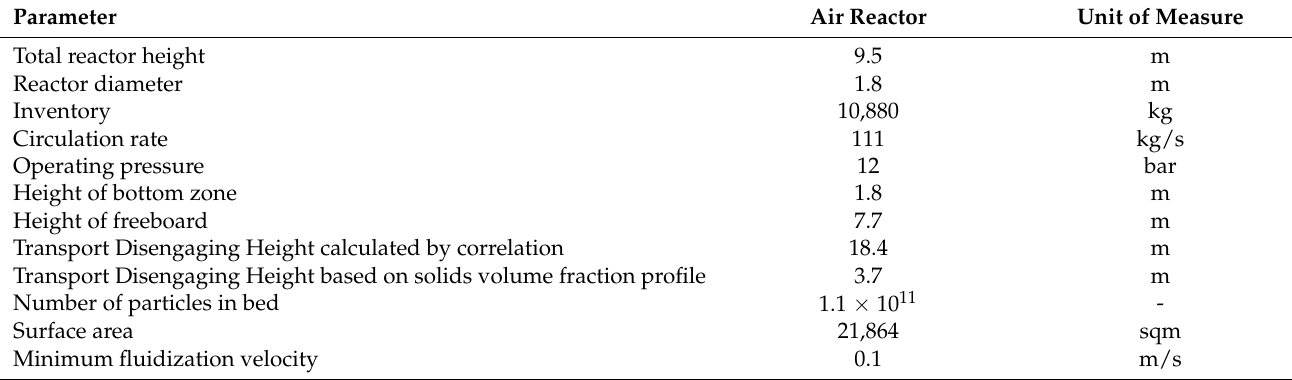
Table 6. Reactor characteristics are derived from the ASPEN Plus V11